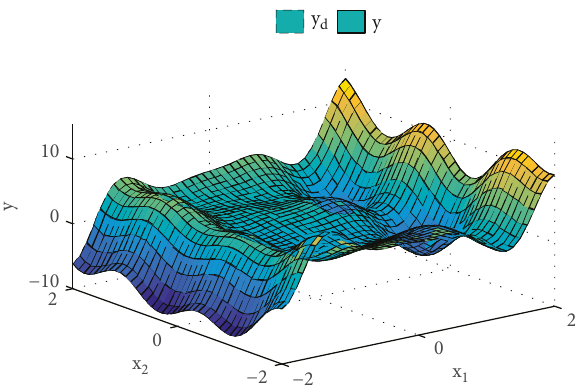
Figure 7: E ff ect of VS-RBF in SIF approximation.